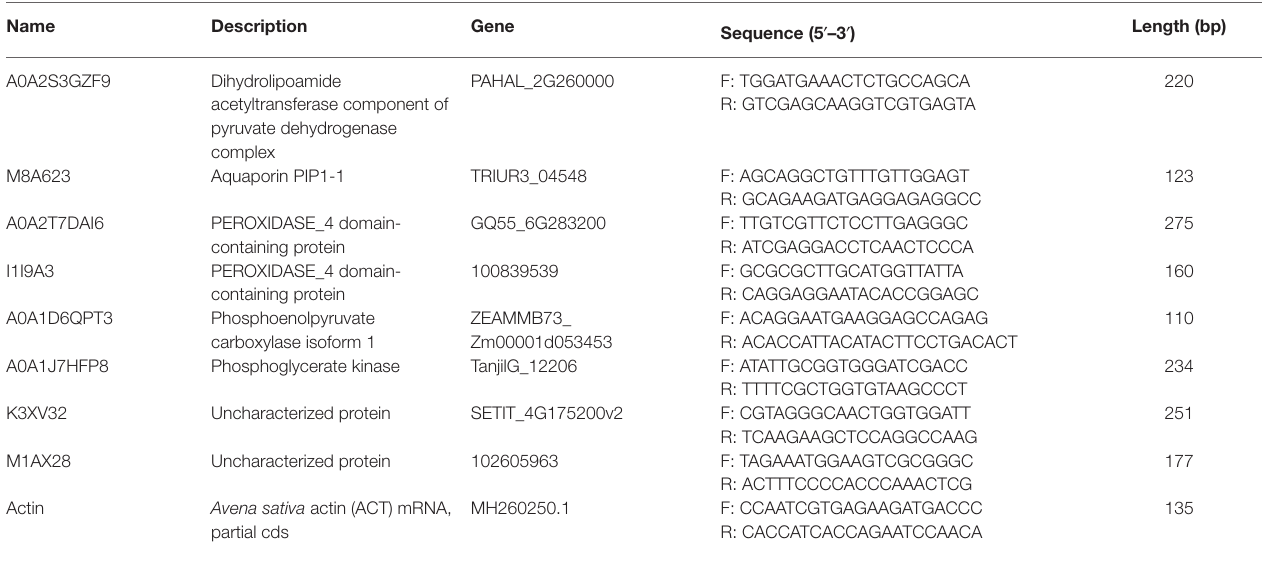
TABLE 1 | Quantitative qRT-PCR